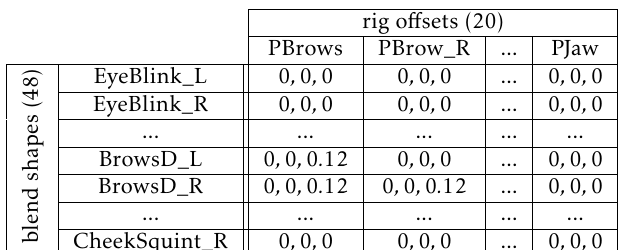
Table 1. An extract of the matrix M mapping the blendshapes to the facial control rig.